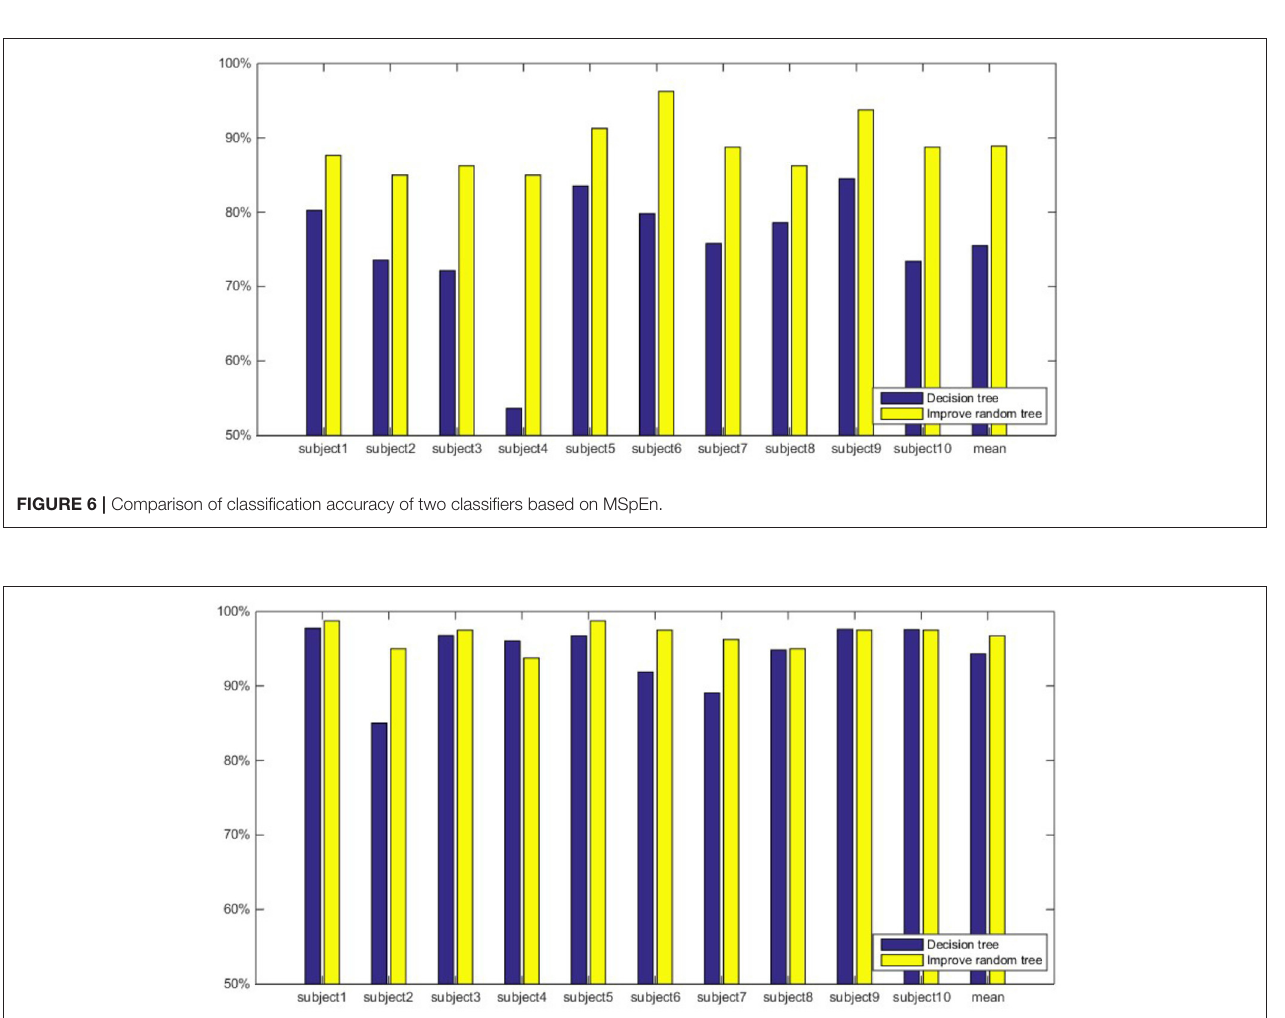
FIGURE 7 | Comparison of classification accuracy of two classifiers based on E i .